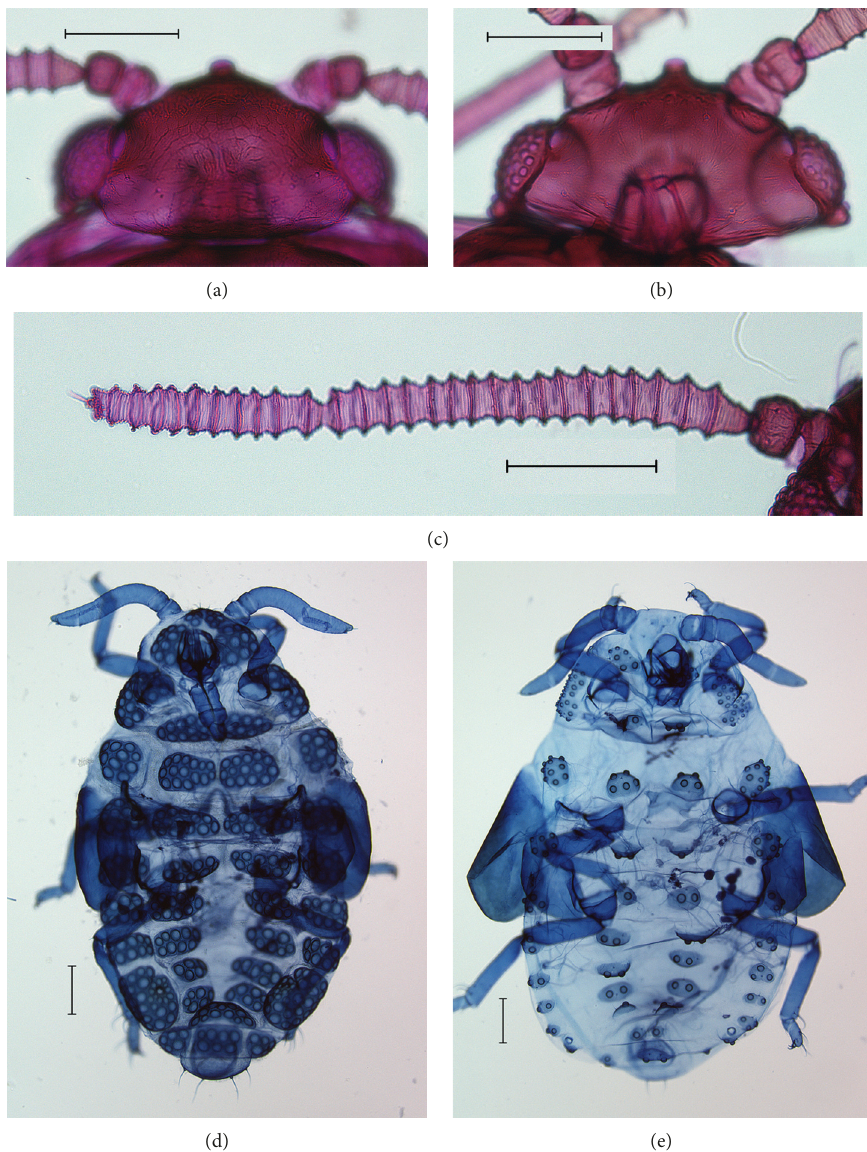
Figure 5: Alates and wingpadded nymphs of Neothoracaphis glaucae and N. yanonis : (a) head of the alate of N. glaucae (collected from Q. glauca as a nymph in Shinkiba, Tokyo, Japan, on 25 November 2013 and fixed on 8 December 2013); (b) head of the alate of N. yanonis (collected from Distylium racemosum in Tama, Tokyo, on 20 November 2013); (c) left antenna of the alate of N. glaucae (collected from Q. glauca as a nymph in Shinkiba on 14 November 2013 and fixed on 26 November 2013); (d) fourth-instar nymph of N. glaucae (collected from Q. glauca in Shinkiba on 14 November 2013); (e) fourth-instar nymph of N. yanonis (collected from Q. serrata in Tama on 1 December 2013). Scale bars: 100 μ